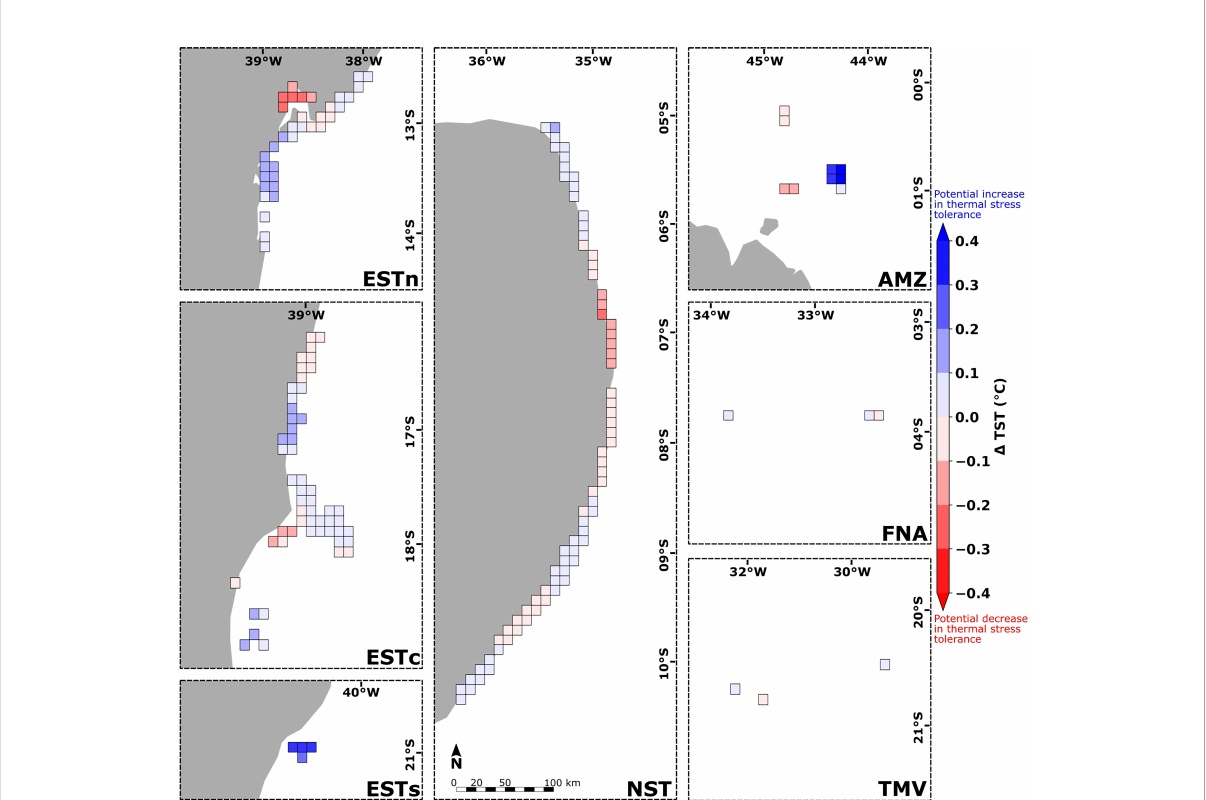
FIGURE 9 Spatial distribution of the difference between the thermal stress thresholds and connectivity-in fl uenced TST cp calculated for the 180 reef sites along the Brazilian continental margin (in gray). Blue and red colors indicate reef sites with potential increase and decrease in thermal stress tolerance, respectively. Ecoregions: Eastern-south (ESTs); Eastern-center (ESTc); Eastern-north (ESTn); Northeastern (NST), Amazon (AMZ), Fernando de Noronha-Atol das Rocas (FNA), Trindade-Martim Vaz Islands